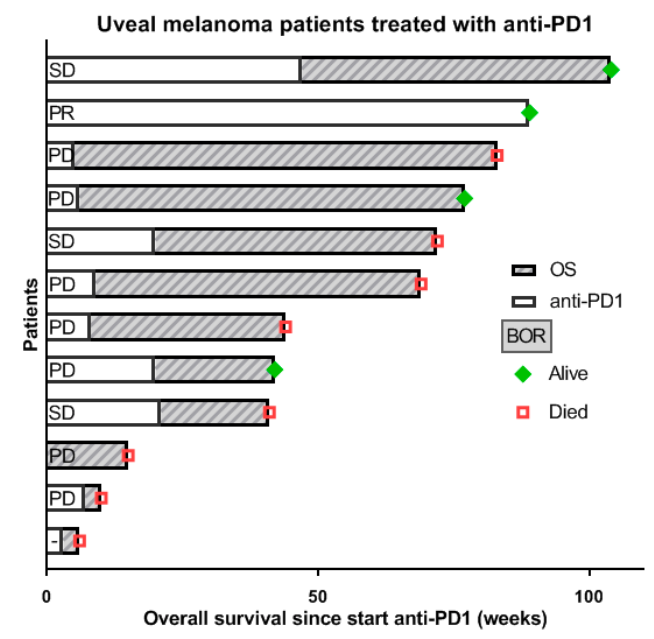
Figure 5. Best response and survival of 12 metastatic UM patients treated with an anti-PD1 antibody (no clinical trial participation).